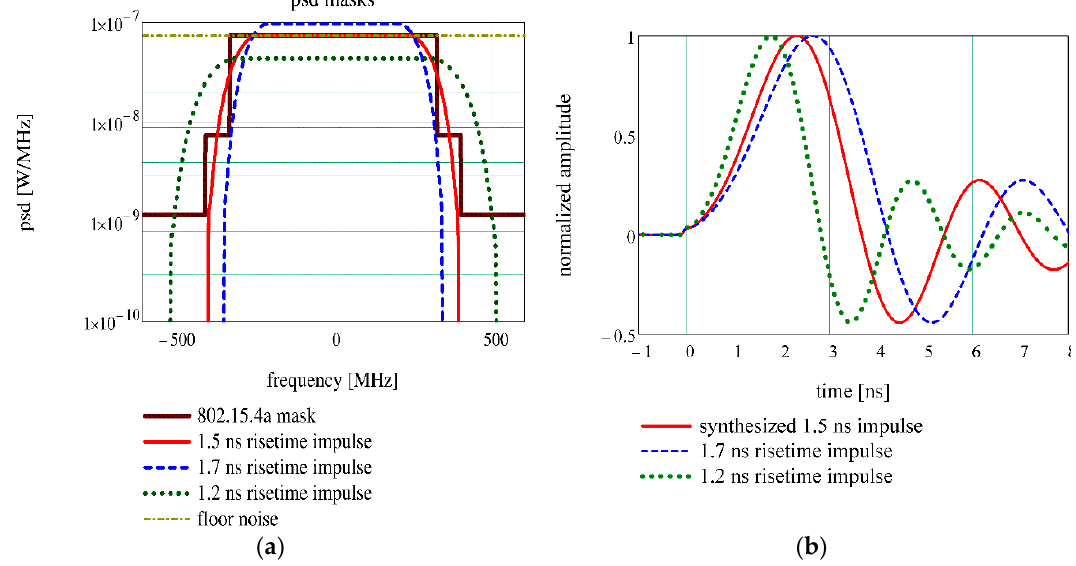
Figure 1. UWB impulse synthesis: ( a ) Spectral masks; ( b ) The pulses in time domain.